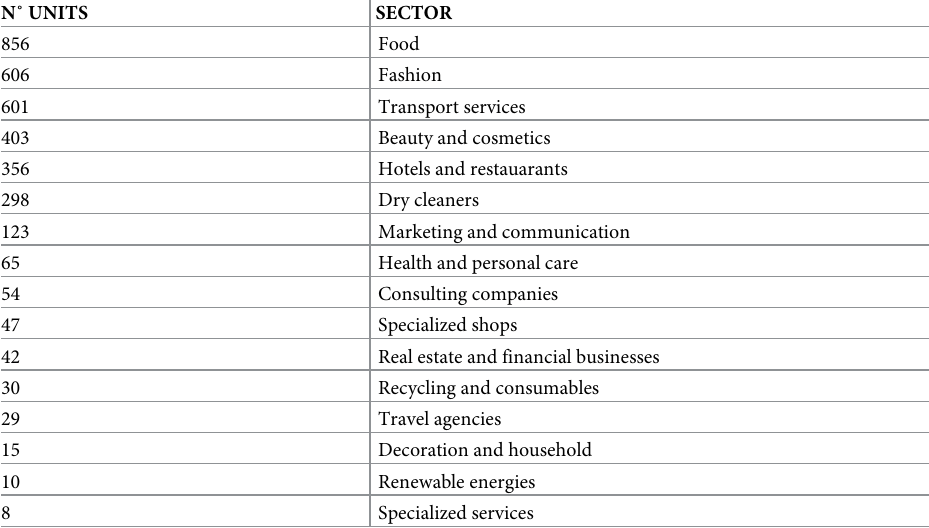
Table 2. Number of outlets per sector in Latin American